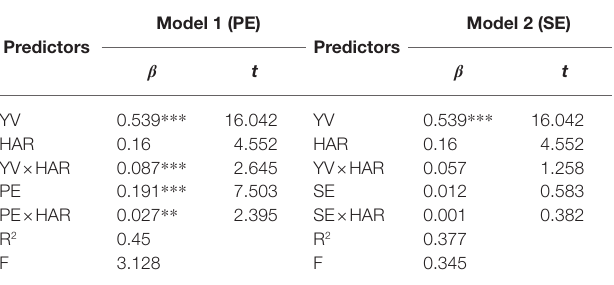
TABLE 4 | Moderated mediation effects of program engagement and safety on positive youth development.